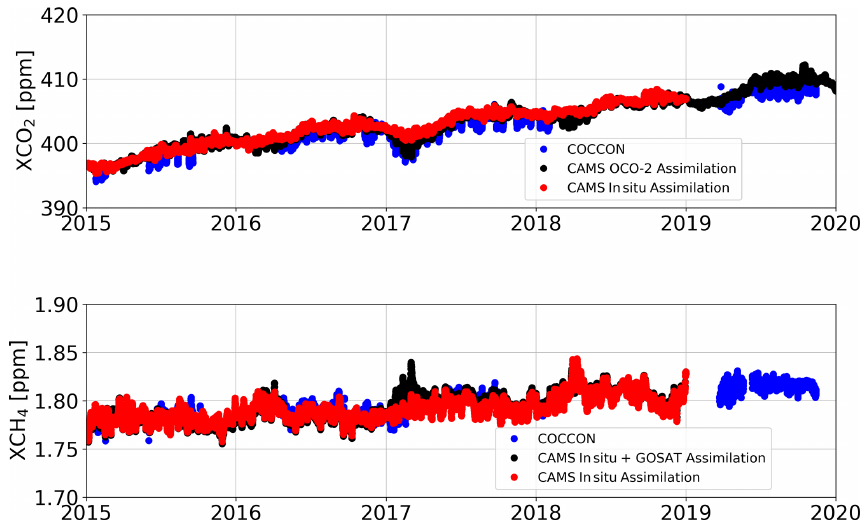
Figure 14. Column-averaged dry-air mole fraction daily mean time series for XCO 2 and XCH 4 at Gobabeb, Namibia. COCCON measure- ments are shown as blue dots, CAMS model data as red and black dots. For COCCON, we show hourly pooled data; for CAMS, we show 3-hourly model output for XCO 2 and 6-hourly model output for XCH 4 .